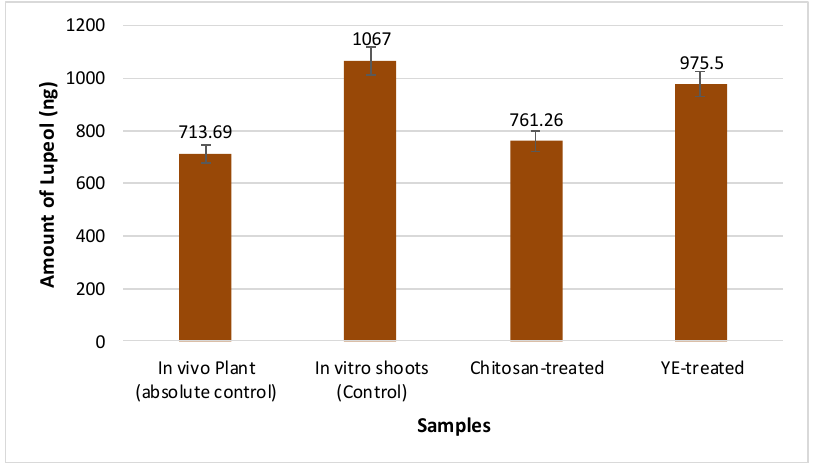
Figure 5. Quantification of lupeol in the selected samples of C.